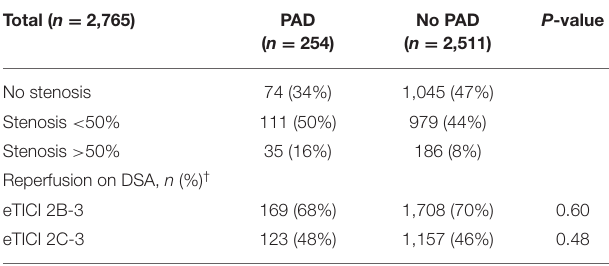
TABLE 1 | Baseline characteristics of ischemic stroke patients with peripheral artery disease (PAD) compared with no